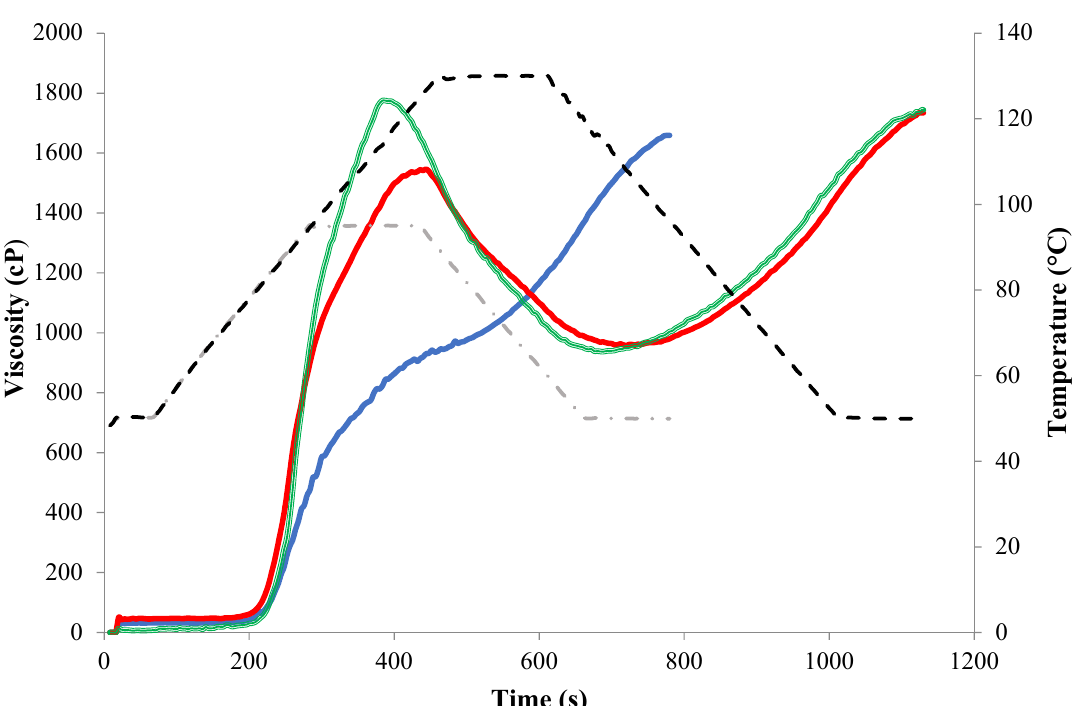
Figure 1. Pasting profiles of whole bean flour with different mediums and two different temperature profiles. The same red kidney bean flour was used to perform the three pasting profiles represented in this figure. Blue line, pasting profile with holding time at 95 °C using water; Red line, pasting profile with holding time at 130 °C using water; Green line, pasting profile with holding time at 130 °C using brine (1.5% sucrose, 1.2% NaCl, 0.03% CaCl 2 ). Discontinues grey and black lines represent the temperature as a function of time in standard (95 °C) and pressurized high temperature (130 °C) RVA tests, respectively.